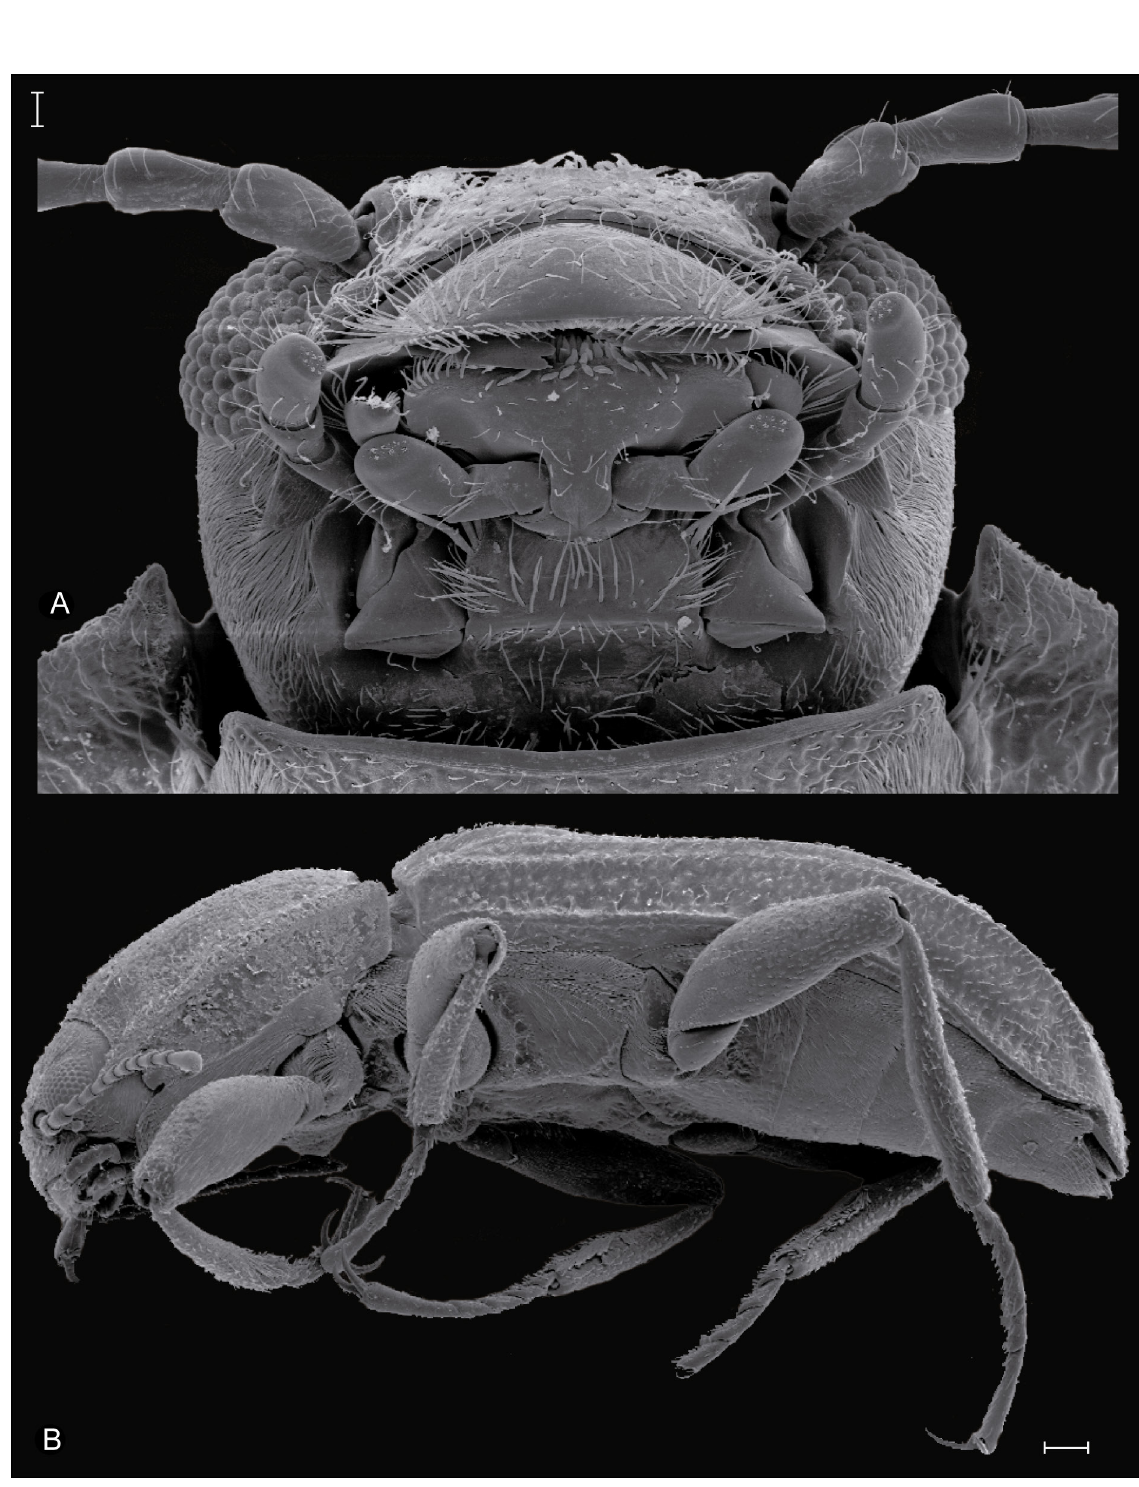
Fig. 8. Spanglerelmis xiririca Polizei & Bispo gen. et sp. nov. under scanning electron microscope, ♂. A . Head in ventral view (MZSP31481). B . Habitus in lateral view (MZSP31482). Scale bars: A = 0.02 mm; B = 0.1